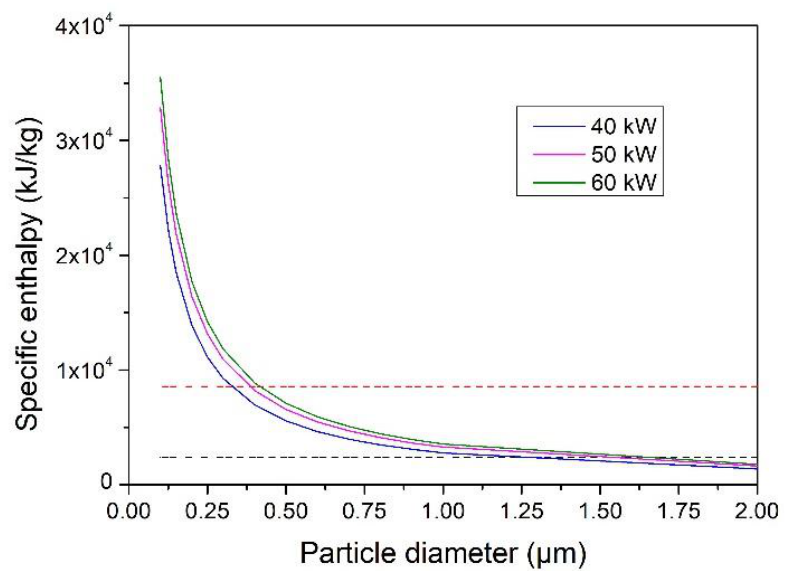
Figure 9. Effect of the torch net power on the specific enthalpy of particles stored over their travel in the free jet (from nozzle exit to substrate standoff distance); the horizontal red dotted line corresponds to the YSZ evaporation enthalpy (8561 kJ/kg) and black dotted lines to the YSZ melting enthalpy (2386 kJ/kg). 40 SLPM of argon, 8 SLPM of hydrogen, chamber pressure: 100 Pa.